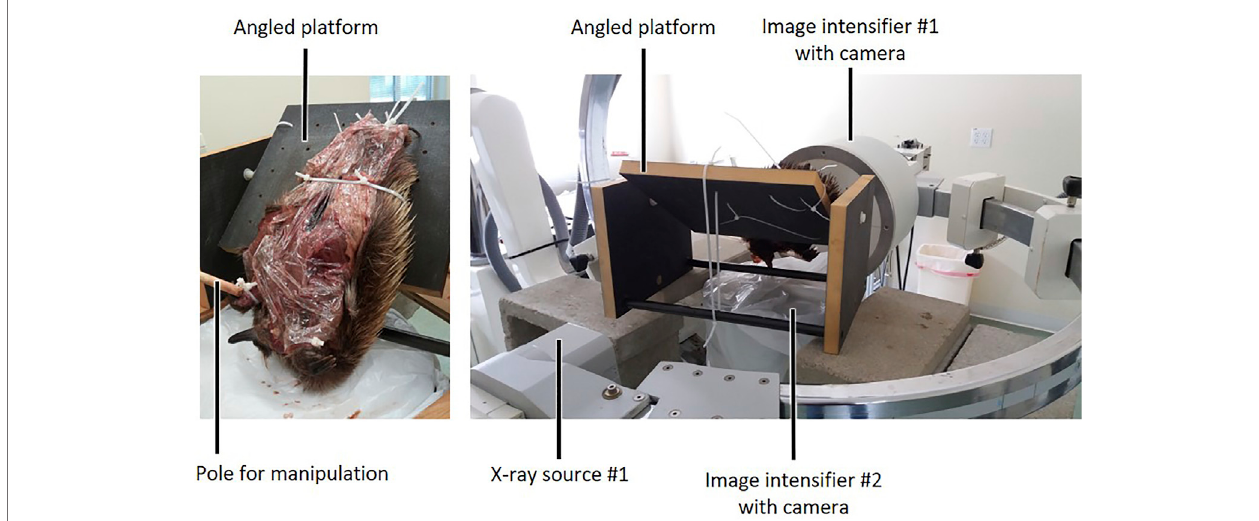
FIGURE2| Experimental set-up for exvivo passivemanipulationofechidna cadaverforelimbs. Aftermarkers wereplaced inbones and muscles, each animal was covered with plastic wrap to prevent drying out, tied to a custom-made carbon fi bre platform oriented to allow limb manipulation, and placed in the fi eld of view of two refurbished c-arm fl uoroscopes for data